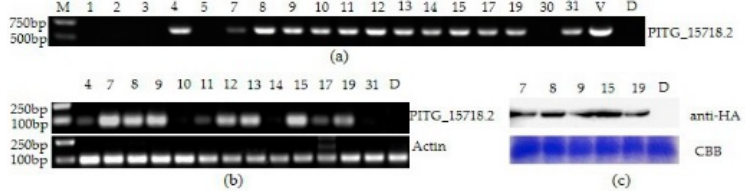
Figure 2. Validation of positive transgenic lines of PITG_15718.2 potato (D é sir é e). ( a ) PCR detected 18 transgenic individuals using PITG_15718.2 -specific primers with agarose gel electrophoresis. A total of 13 positive lines out of 18 lines were obtained; ( b ) detection of the expression level of PITG_15718.2 using semiquantitative RT-PCR for 13 positive lines. The StEF gene was the endogenous control. PITG_15718.2 was highly expressed in lines 7, 8, 9 and 15; ( c ) western blot showing that PITG_15718.2 was highly accumulated in lines 7, 8, 9 and 15. Total protein extracts from S. tuberosum (D é sir é e and lines 7, 8, 9 and 15). HA-tagged fusion proteins were detected by probing western blots with HA antibodies.